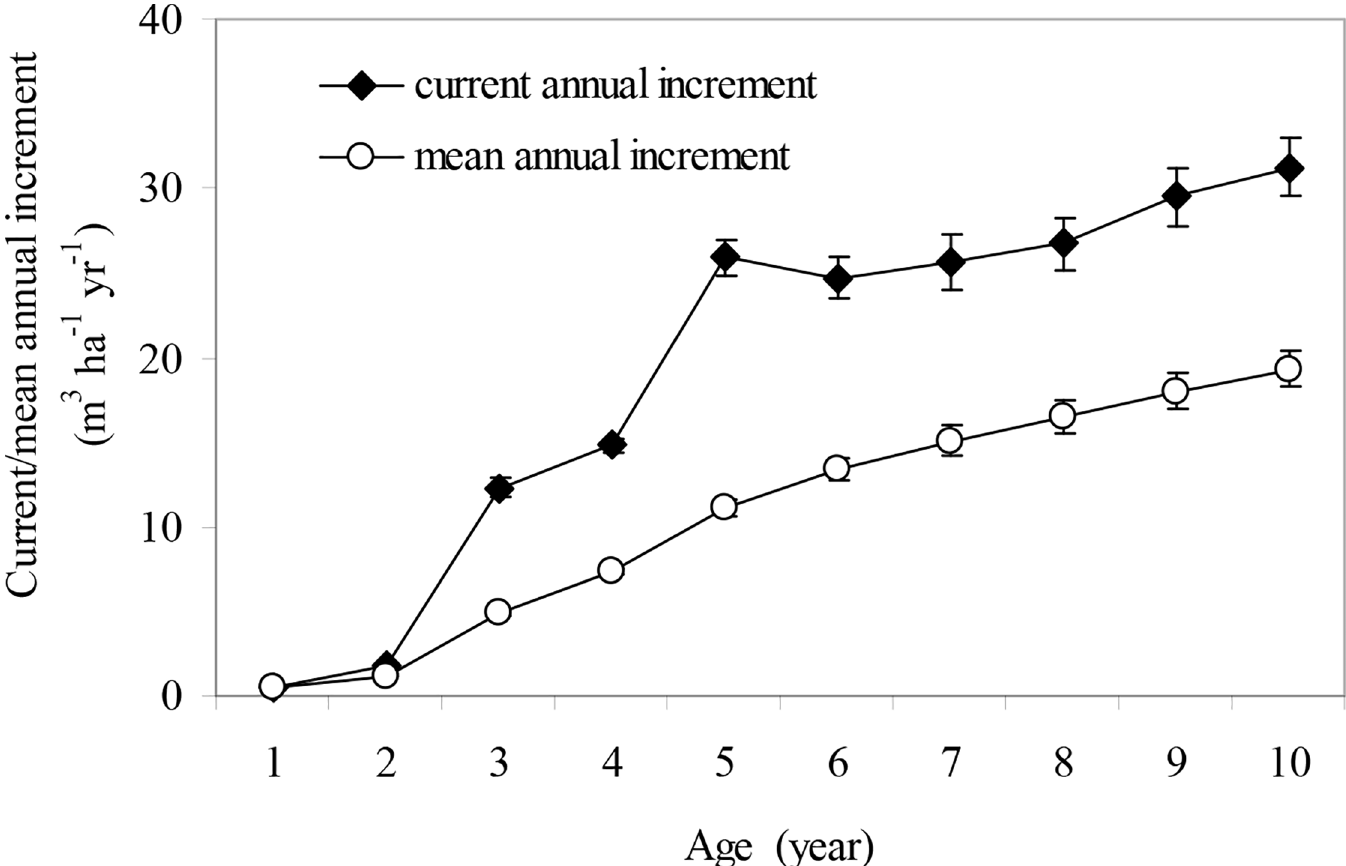
Fig 2. Current annual increment and mean annual increment of stand volume of P . deltoides plantation at Zhoushan Forestry Farm, Jiangsu, China. Error bars represent standard error (SE).